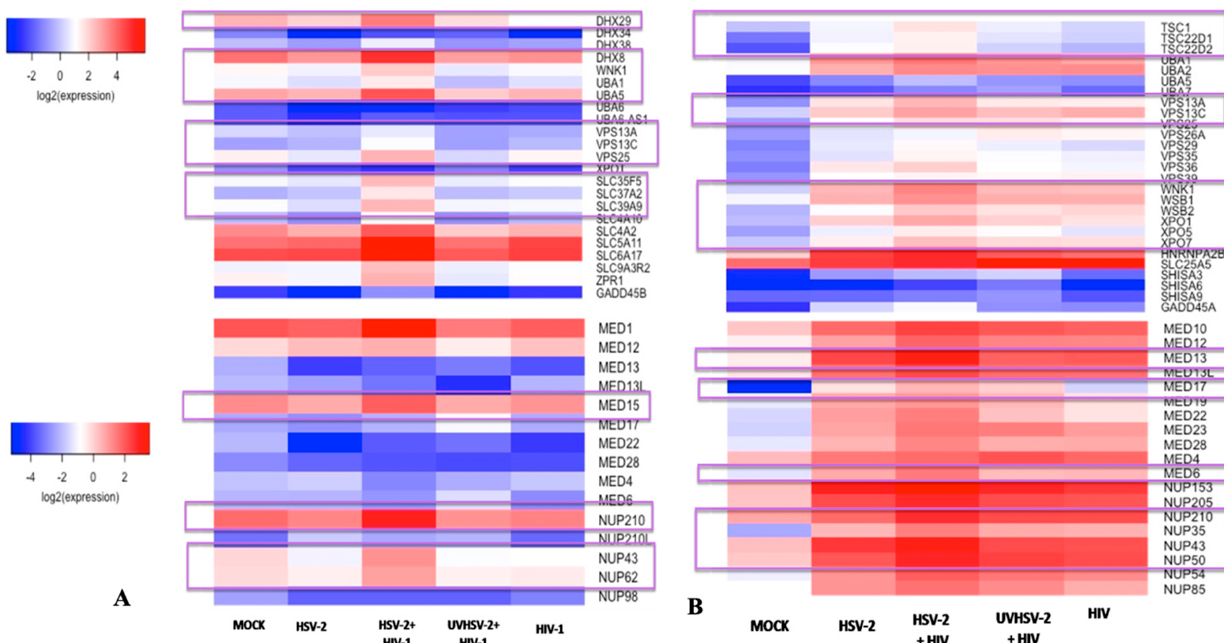
Figure 5. Heatmap of differentially expressed genes in infected T-cell lines. Log 2 (RPKM) values of T-cell lines (A3R5.7 and CEM CCR5+) infected under various conditions were used to draw a heatmap using the ggplots2 program on R-studio. ( A ) Heatmap generated for A3R5.7 cells ( B ). Heatmap generated for CEM CCR5+ T-cell line.